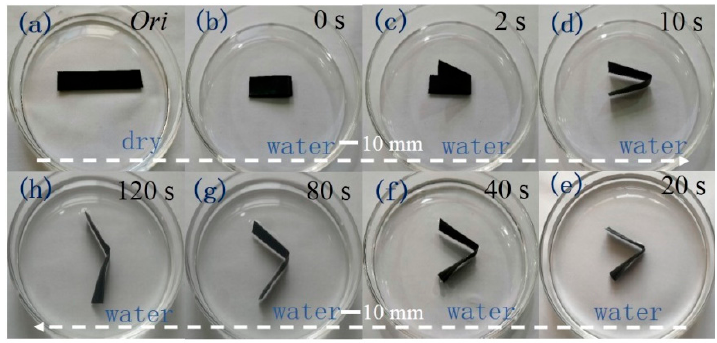
Figure 5. Shape recovery of manually deformed TPU/CNF-C/CNTs film in water.